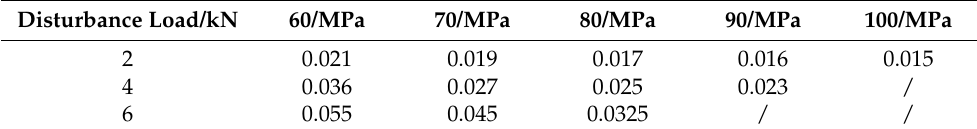
Table 2. Disturbance increment under different disturbance loads.